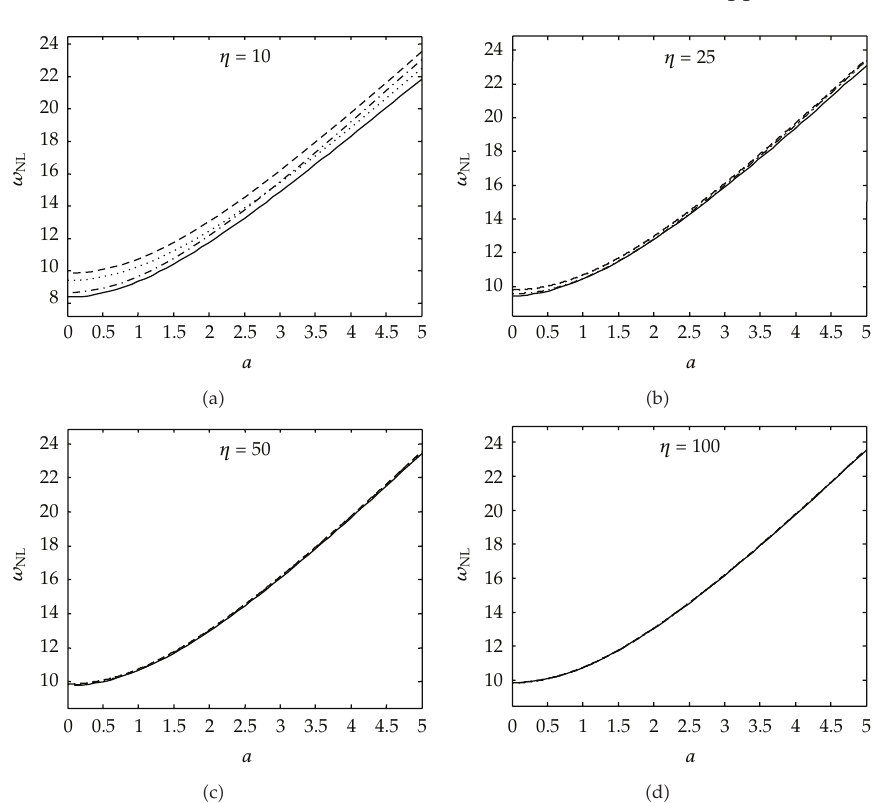
Figure 4: Nonlinear frequency versus nondimensional amplitude for di ff erent slenderness ratios (cid:2) - - - (cid:3) Bernoulli-Euler’s, (cid:2) ··· (cid:3) Rayleigh’s, (cid:2) - · - (cid:3) shear, and (cid:2) — (cid:3) Timoshenko’s beam